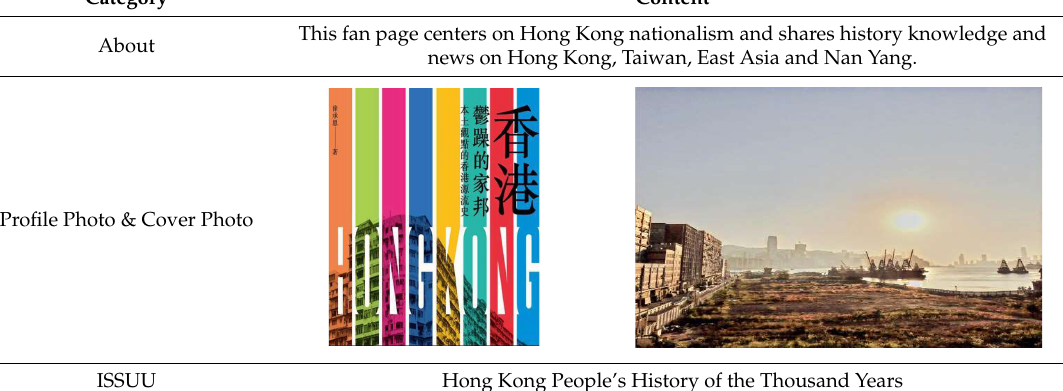
Figure 1. A Screenshot of Fan Page of HNH.